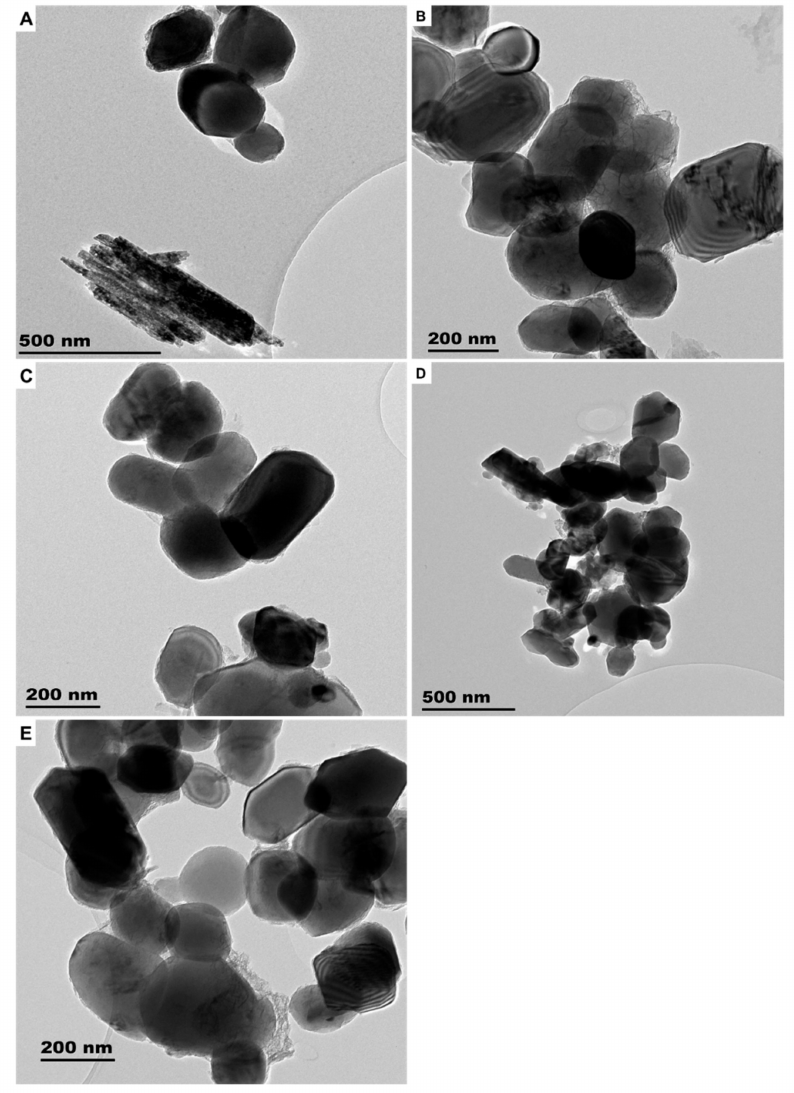
Figure 9. TEM images obtained from the analysis of PA1 ( A ), PA2 ( B ), PA3 ( C ), PA4 ( D ), and PA5 ( E